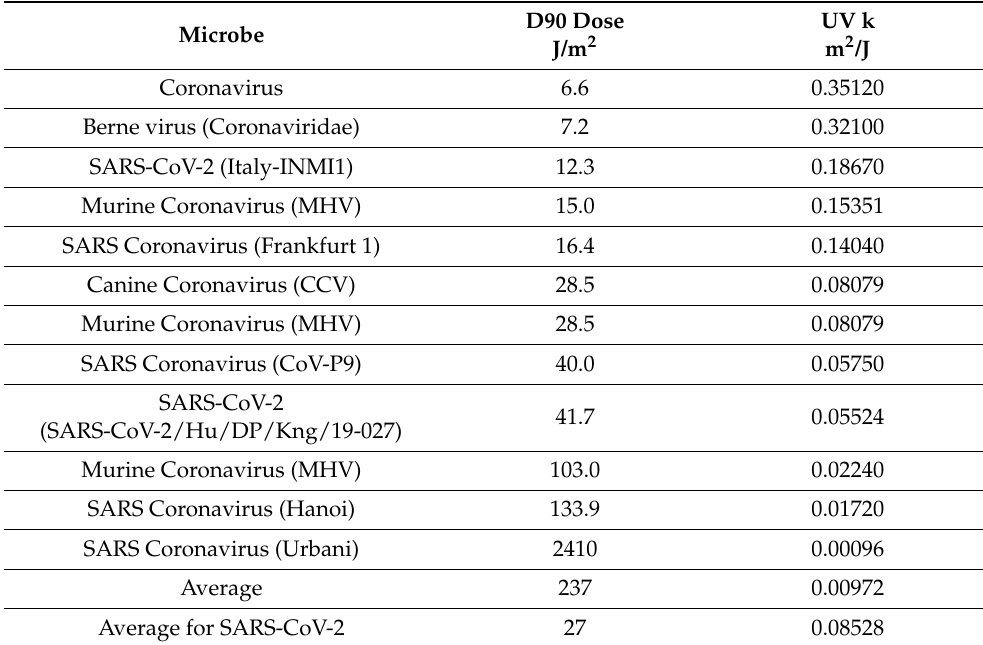
Table 1. Summary of ultraviolet studies on coronaviruses (data processed from